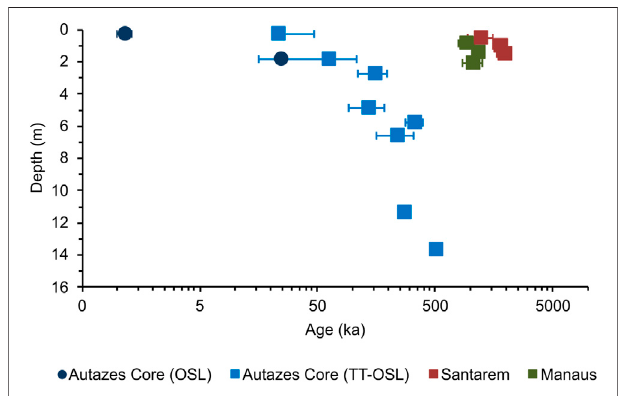
FIGURE 6 | OSL and TT-OSL ages versus depth for the studied samples.